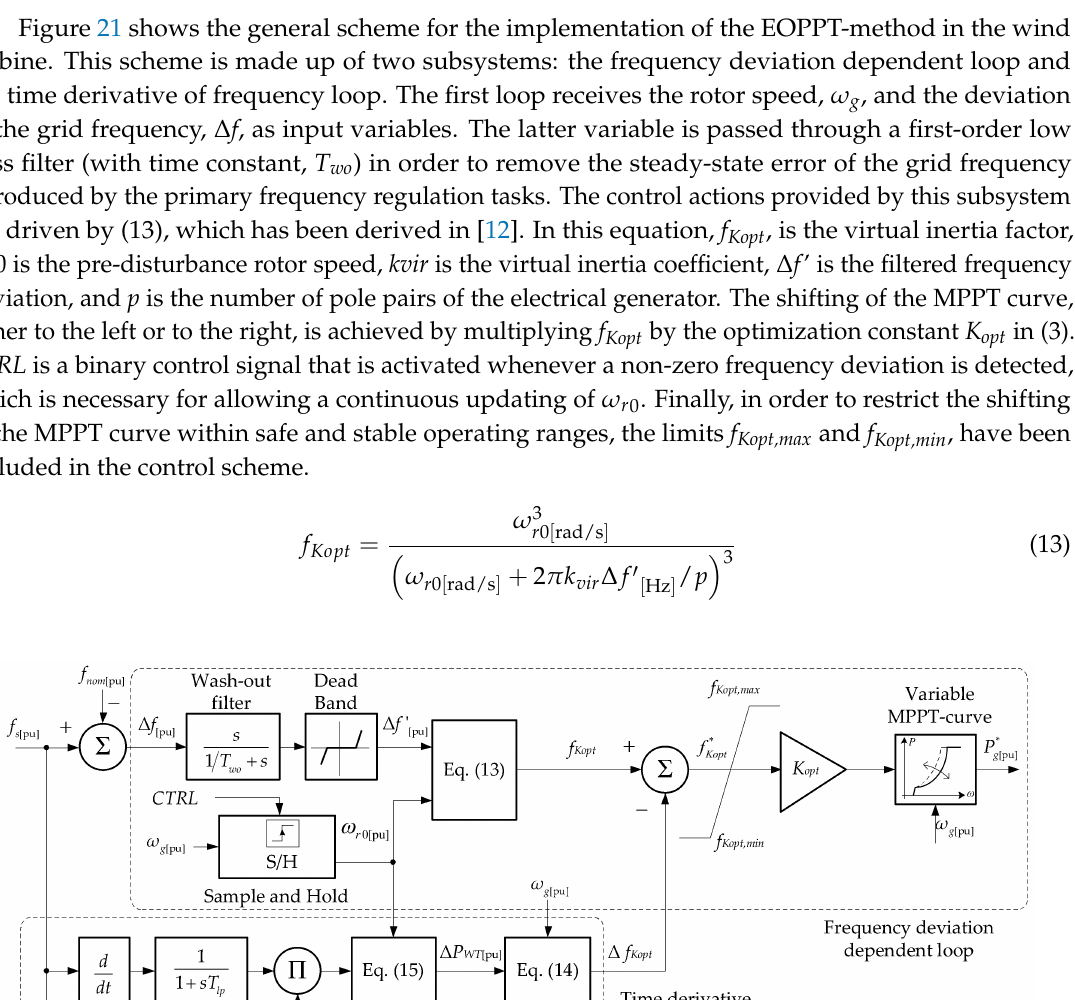
Figure 20. MPPT curve shifting procedure.